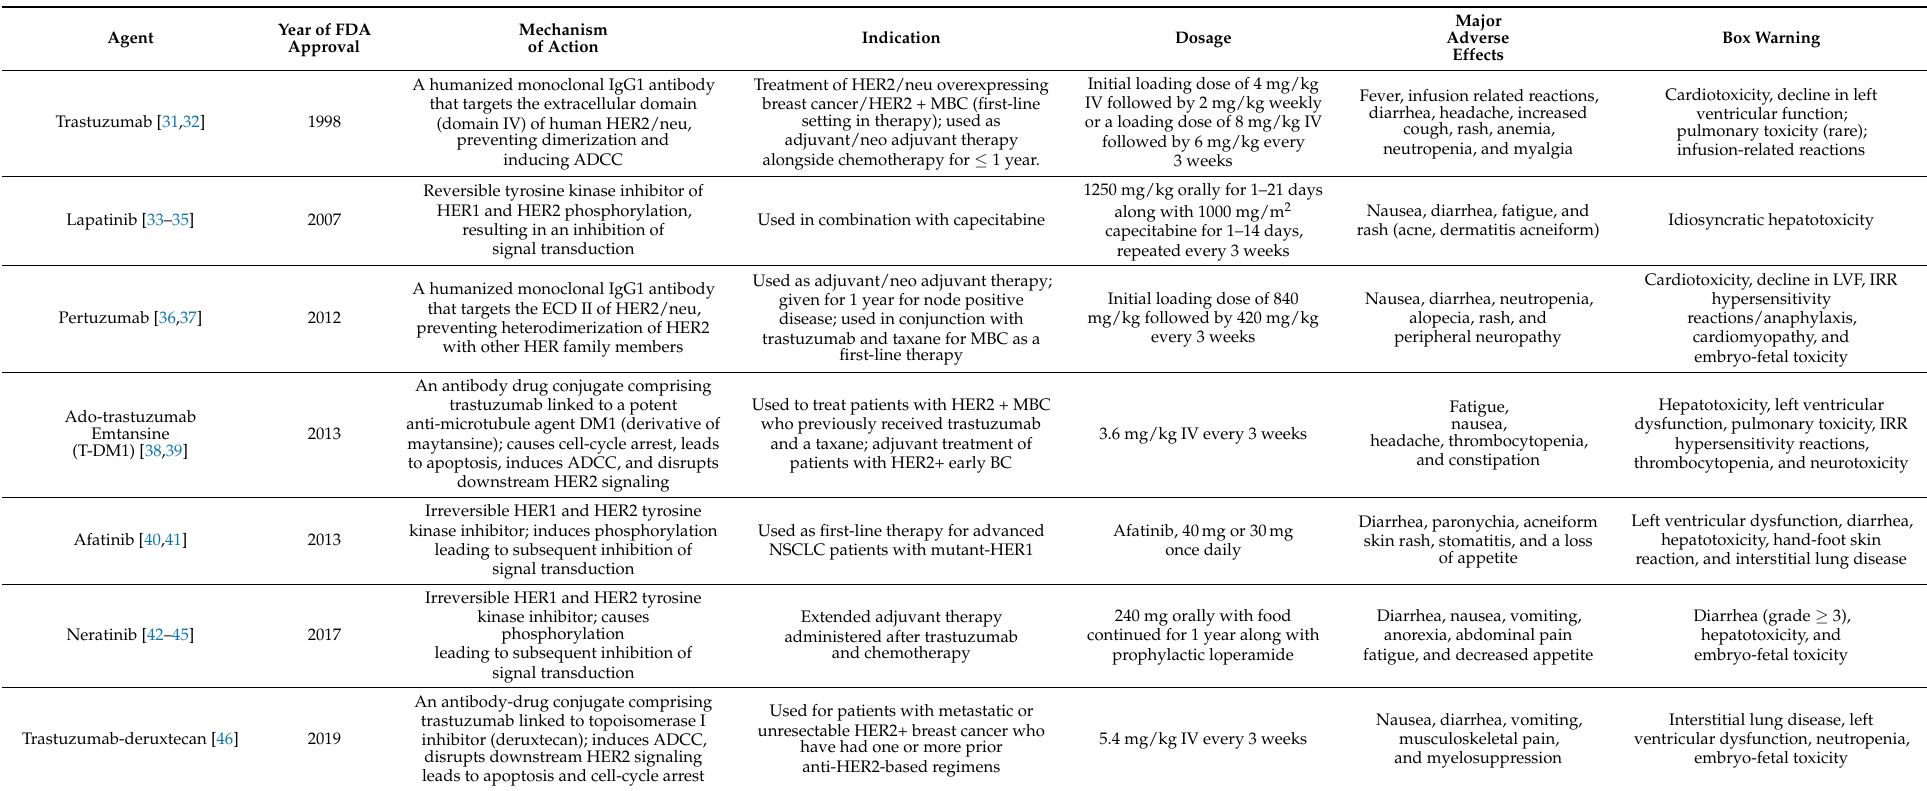
Table 1. Anti-HER2 targeted therapies approved by the US